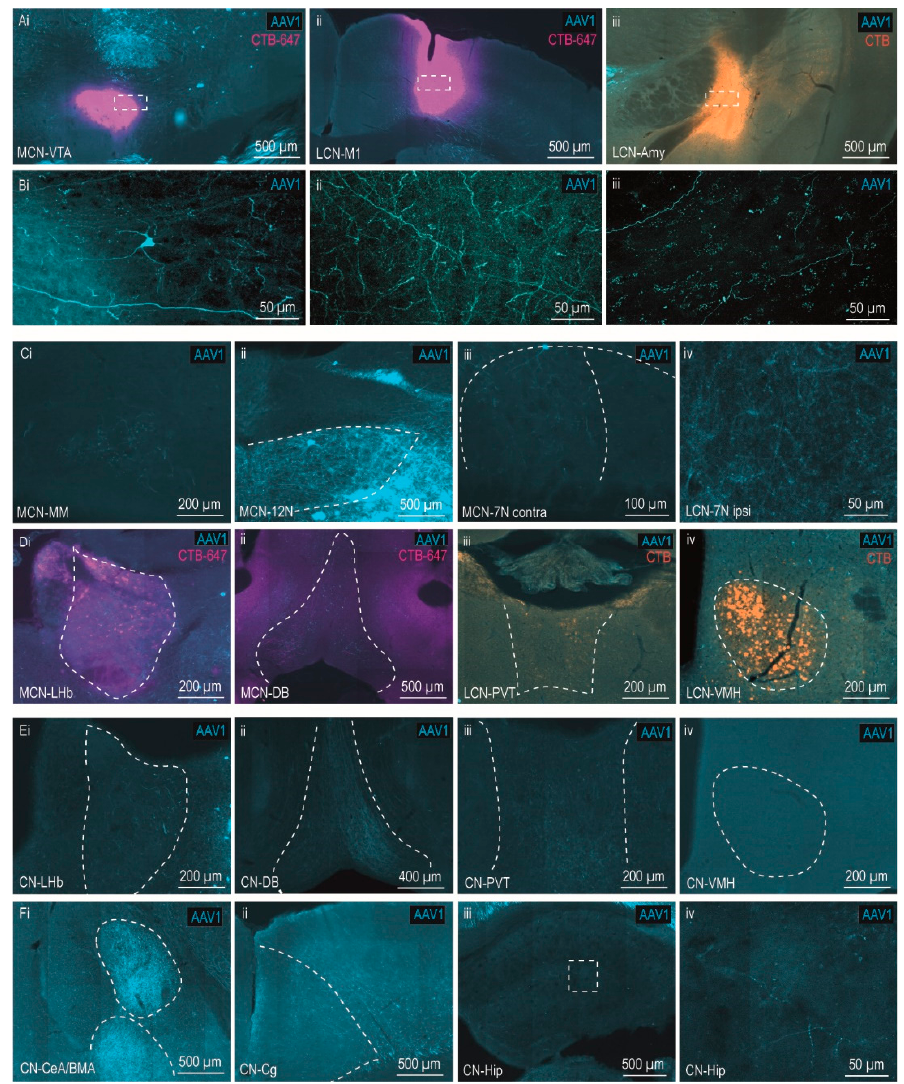
Figure 4. Brain-wide disynaptic projections from MCN, LCN and MCN-INT-LCN (CN). ( Ai-iii ) Overview of transsynaptically labeled AAV1+ fibers from the injections shown in Figures 2 and 3, specifically in the CTB injection spots for VTA; (Ai), labeling in M1 (Aii) and amygdala (Aiii). Blue, magenta and orange indicate AAV1-Cre, CTB-647, and CTB, respectively. ( Bi-iii ) Confocal scans of transsynaptic labeling (fibers) in areas indicated in A; (Bi) 3D image of 20× z-stack in VTA; (Bii) 20× confocal image in M1; and (Biii) 40× 3D image of 40× z-stack in amygdala. ( Ci-iv ) Transsynaptic labeling (AAV1+ fibers) in mammillary bodies (MM) following injection in MCN; (Ci), labeling in 12N following injection in MCN; (Cii), labeling in contralateral medial 7N following injection in MCN; (Ciii), labeling in ipsilateral lateral 7N following injection in LCN (Civ). ( Di-iv ) putative tri- synaptic connections; MCN-VTA cATR tracing shows colocalization of strong anterograde transsynaptic and retrograde labeling in LHb and DB (Di and Dii, respectively). LCN-amygdala cATR tracing shows absence of anterograde transsynaptic fibers in PVT (Diii) and VMH (Div). ( Ei- iv ) Same areas as in D, but from larger MCN-INT-LCN injections (CN), showing labeling in LHb and DB (Ei and Eii, respectively) similar to those following MCN injections (Di and Dii, respec- tively), strong labeling in PVT (Eiii) in contrast to the absence of LCN projections (Diii), and absence of fibers in VMH (Eiv), similar as following LCN injections (Div). ( F ) Disynaptic fibers for MCN-